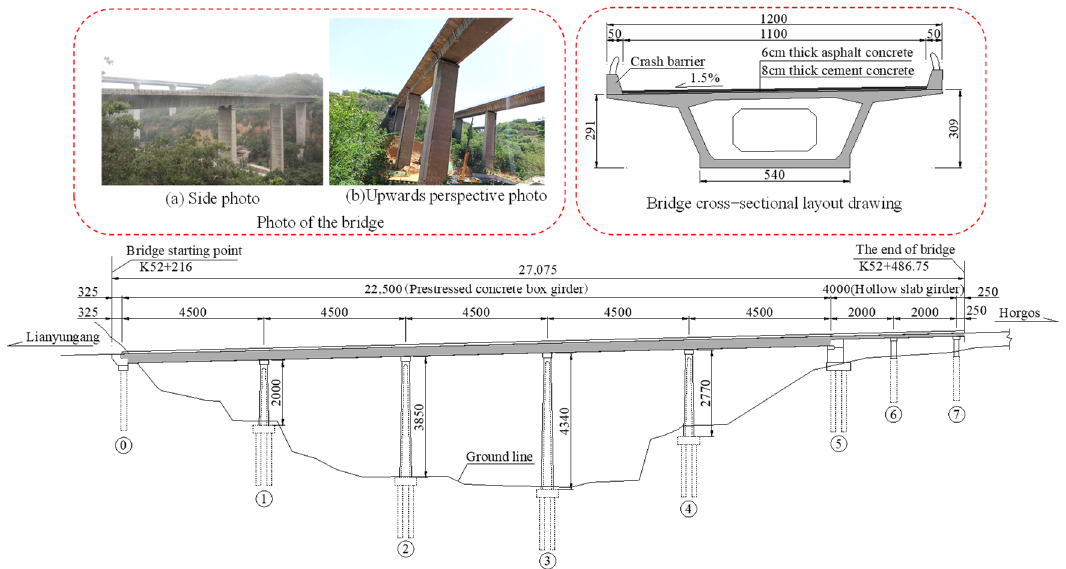
Figure 1. Layout plan and photo of the bridge (unit: cm).